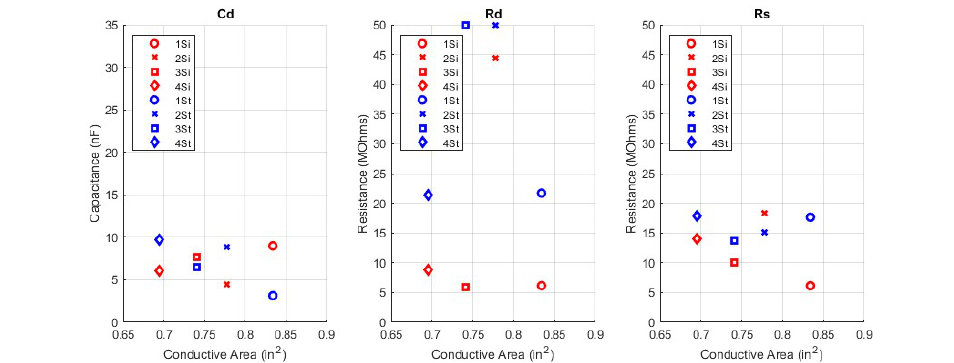
Figure 9. Pattern and Yarn type Comparison versus Circuit Parameters; Patch Surface Area = 5.74 cm 2 , C d ( left ), R d ( middle ), R s ( right ).